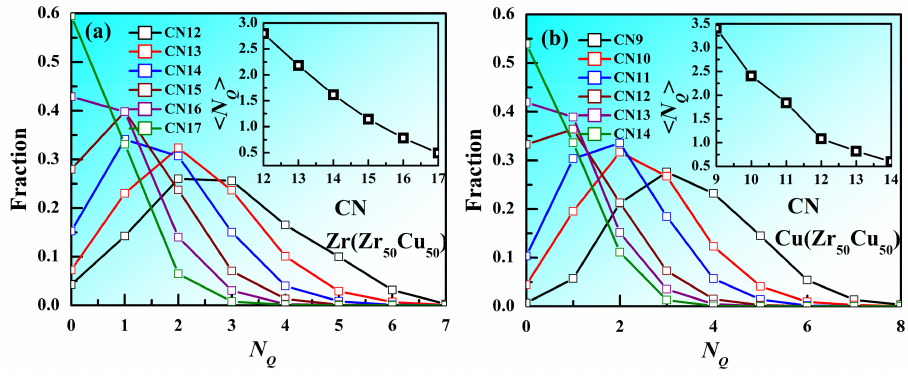
Figure 3. Distribution of N Q for the atoms with different CNs in Zr 50 Cu 50 MG at 300 K. ( a ) Zr, ( b ) Cu. Inset is the average N Q as a function of CN.